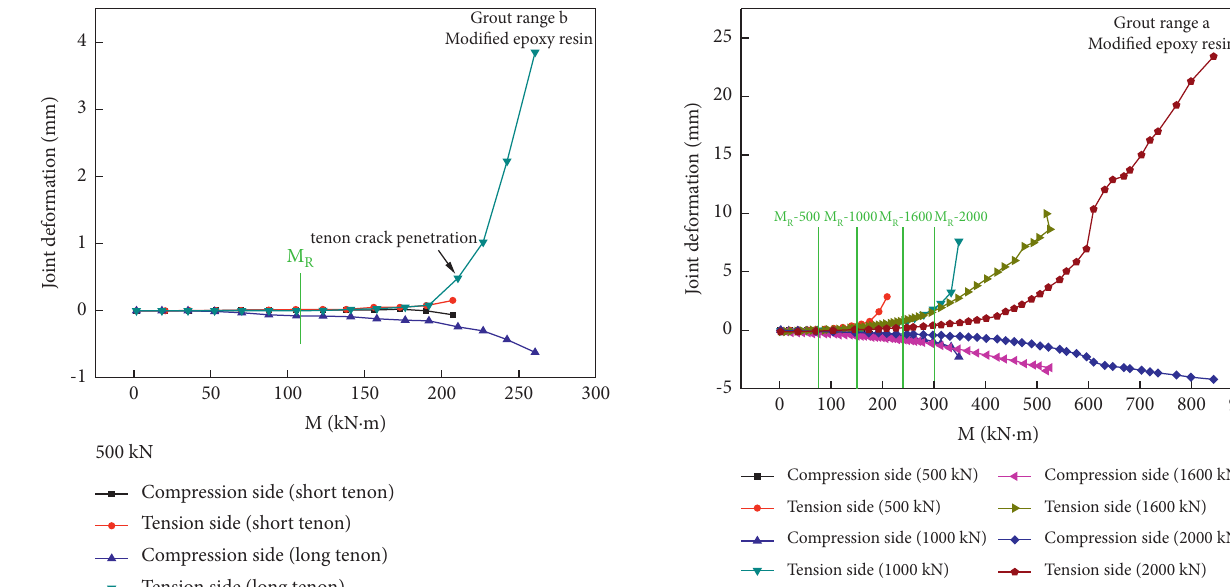
Figure 9: Development law of joint deformation with different tenon lengths.